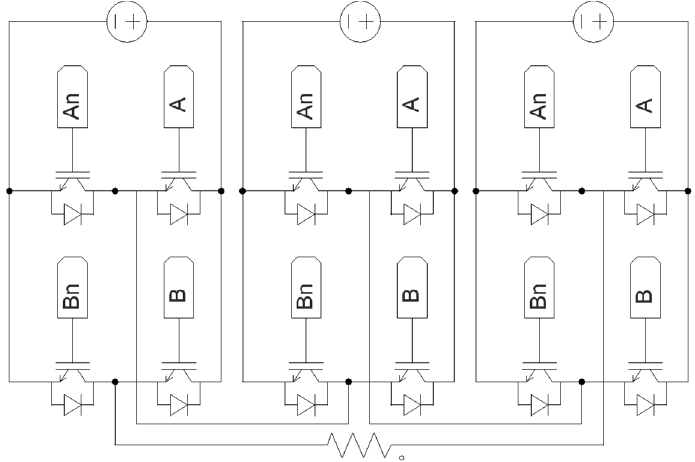
Figure 3. Schematic diagram of the power stage: CHBMI and resistive load.